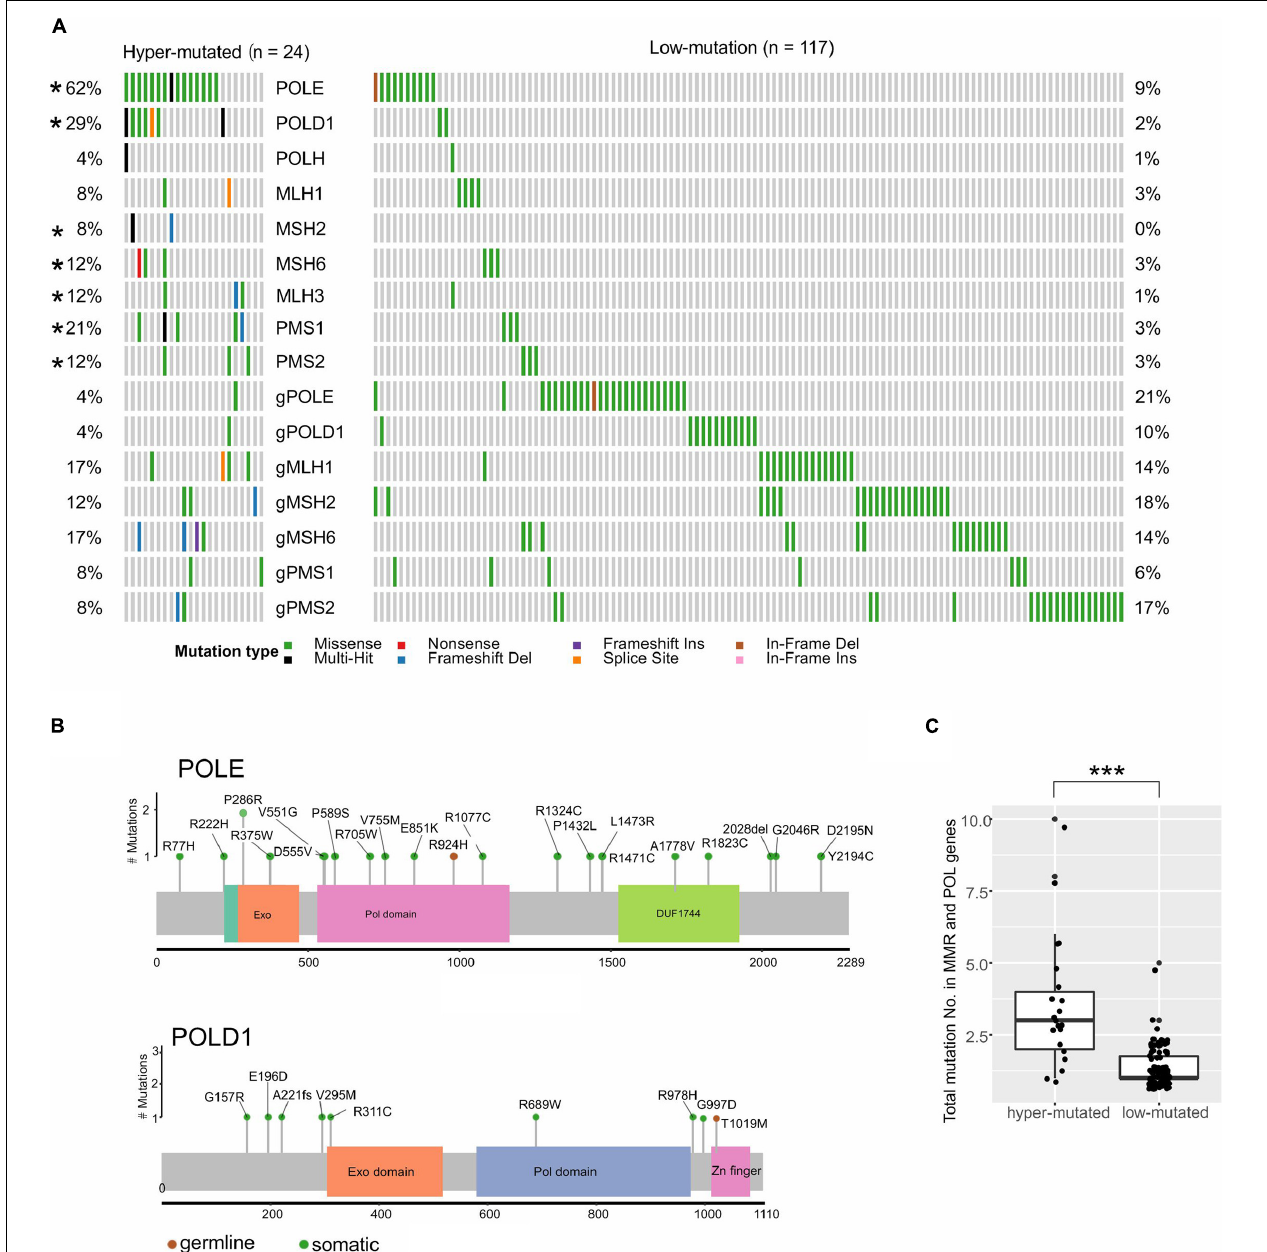
FIGURE 2 | MMR and polymerase genes showed different mutation frequencies in low-mutated and hyper-mutated tumors. (A) Somatic and germline mutations in MMR and polymerase genes. “g” represents germline mutations; * p < 0.05. (B) The lollipop plot shows the scattered amino acid changes in POLE and POLD1. (C) The mutation number of MMR and polymerase genes in each patient; *** p < 0.001.